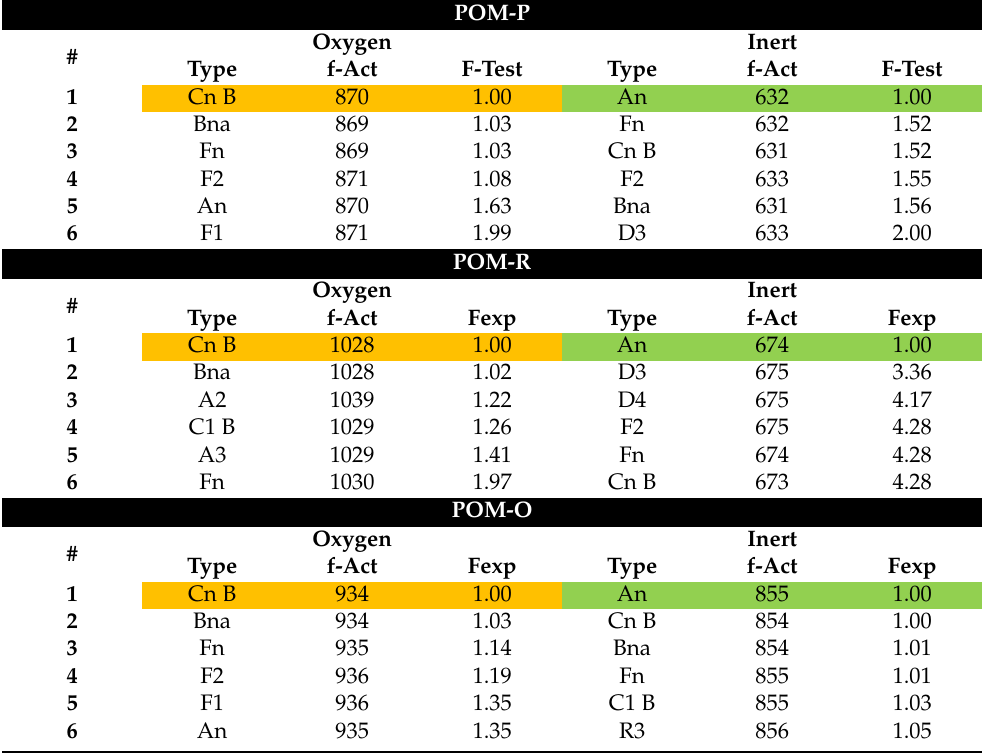
Table 5. Six best fits of kinetic models to experimental results of POM-P, POM-R, and POM-O samples tested in oxygen and inert atmosphere